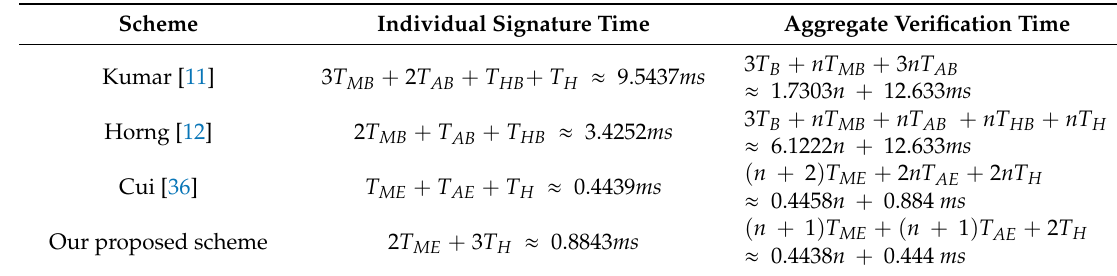
Table 8. The comparison of computation cost in IoTs.